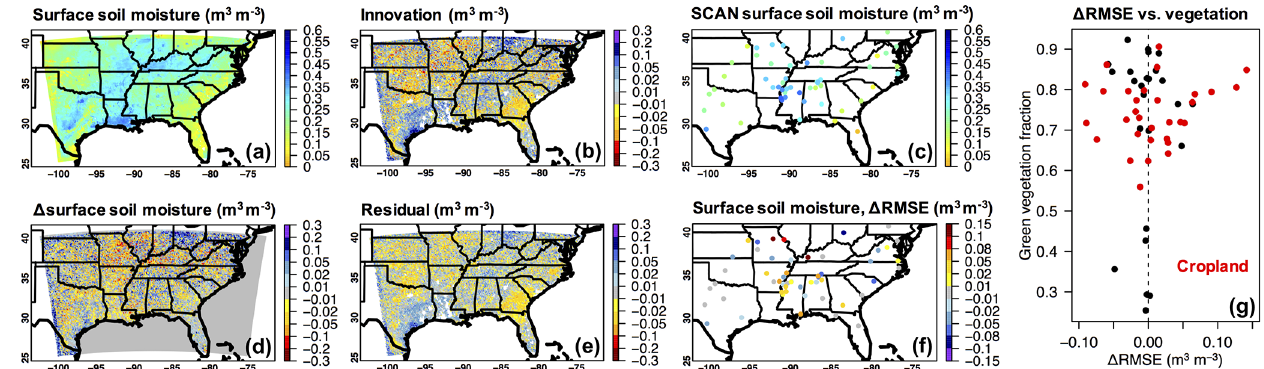
Figure 2. Period-mean (16–28 August 2016) (a) WRF-Chem base case surface-layer (i.e., 0–10cm belowground) soil moisture at initial times and (d) its changes due to the SMAP DA. Panels (b, e) indicate the SMAP DA impacts on the discrepancies between SMAP and modeled surface soil moisture. Panel (c) presents soil moisture measurements at various SCAN sites at ∼ 10cm belowground at WRF-Chem initial times. The SMAP DA impacts on RMSEs of the modeled surface soil moisture, as well as their relationships with the model-based green vegetation fraction, are shown in (f, g) . In (g) , the SCAN sites located in cropland areas according to the model’s land use–cover input are highlighted in red.